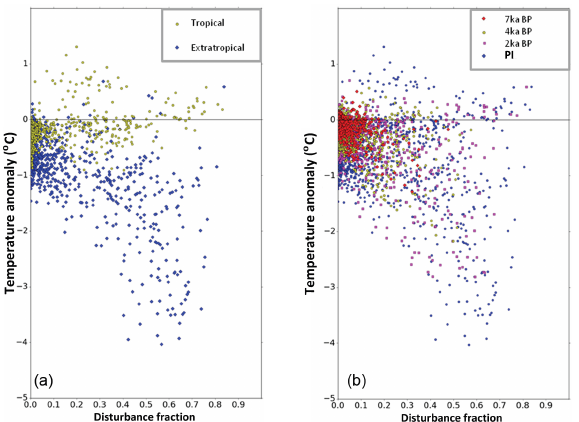
Figure 5. Relationship between the fraction of anthropogenically disturbed land (from KK10) and the resultant JJA temperature anomaly ( ◦ C): (a) for the late pre-industrial (1850CE) period for extratropical and tropical grid cells; (b) for 7, 4, and 2kaBP and late pre-industrial (1850CE) time